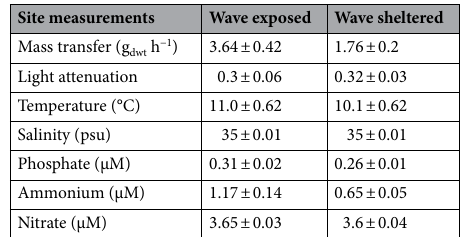
Table 1. Abiotic site measurements of the three wave-exposed and four wave-sheltered sites. Values represent mean ± 95% confidence interval.